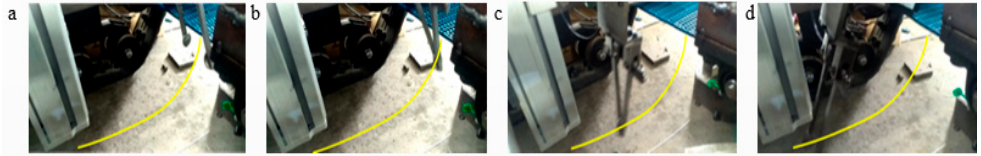
Figure 14. Horizontal planting method. ( a ) Clip seedlings; ( b ) inserting the ridge; ( c ) transplanting; ( d ) complete transplanting.